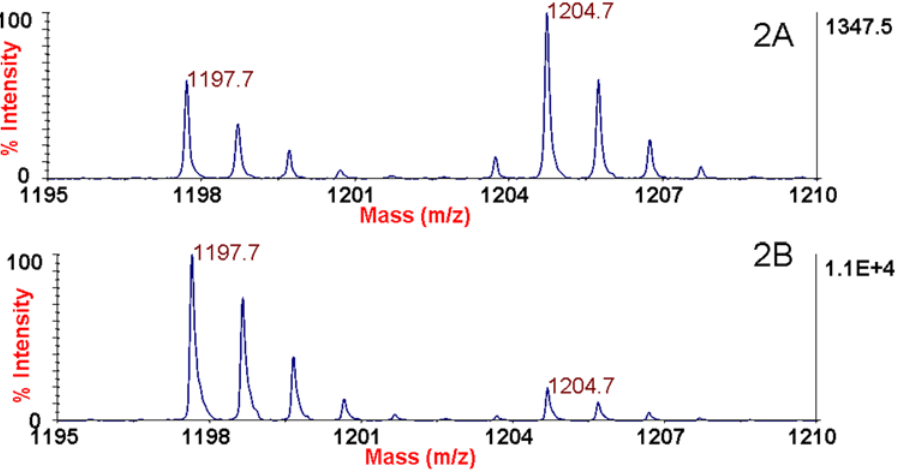
Figure 2. Mass spectra of the Endopep-MS BoNT/A1 reaction with either ING2 (2A) or CR2 (2B) antibodies. The peptide cleavage product indicating BoNT/A1 is present in both cases at m/z 1197.7 and the internal standard is present at m/z